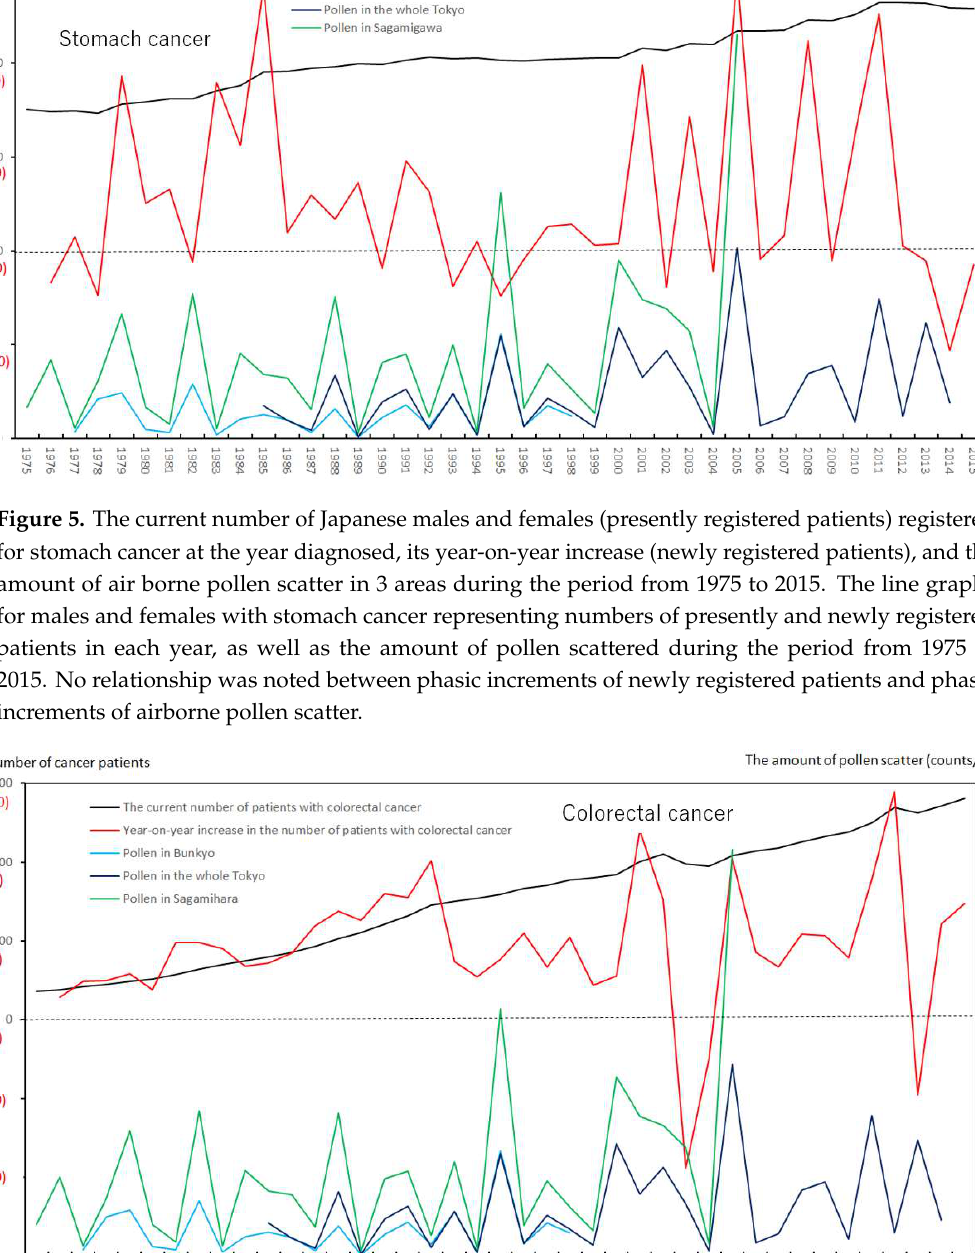
Figure 6. The current number of Japanese males and females (presently registered patients) registered for colorectal cancer at the year diagnosed, its year-on-year increase (newly registered patients), and the amount of air borne pollen scatter in 3 areas during the period from 1975 to 2015. The line graphs for males and females with colorectal cancer representing numbers of presently and newly registered patients in each year, as well as the amount of pollen scattered during the period from 1975 to 2015. No relationship was noted between phasic increments of newly registered patients and phasic increments of airborne pollen scatter.